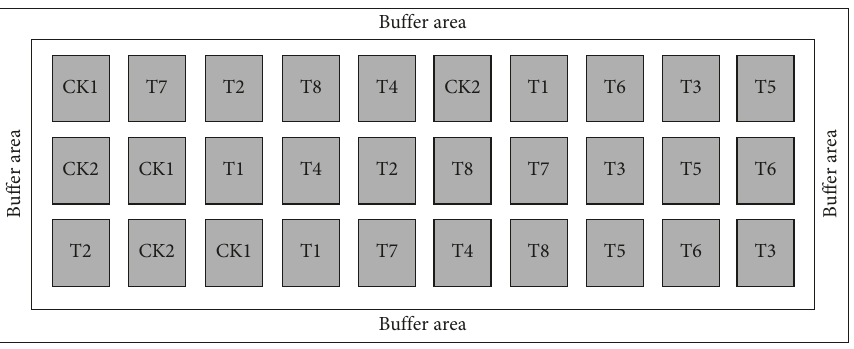
Buffer Figure 3: Layout of experiment plots of different interlayer soil-coal gangue